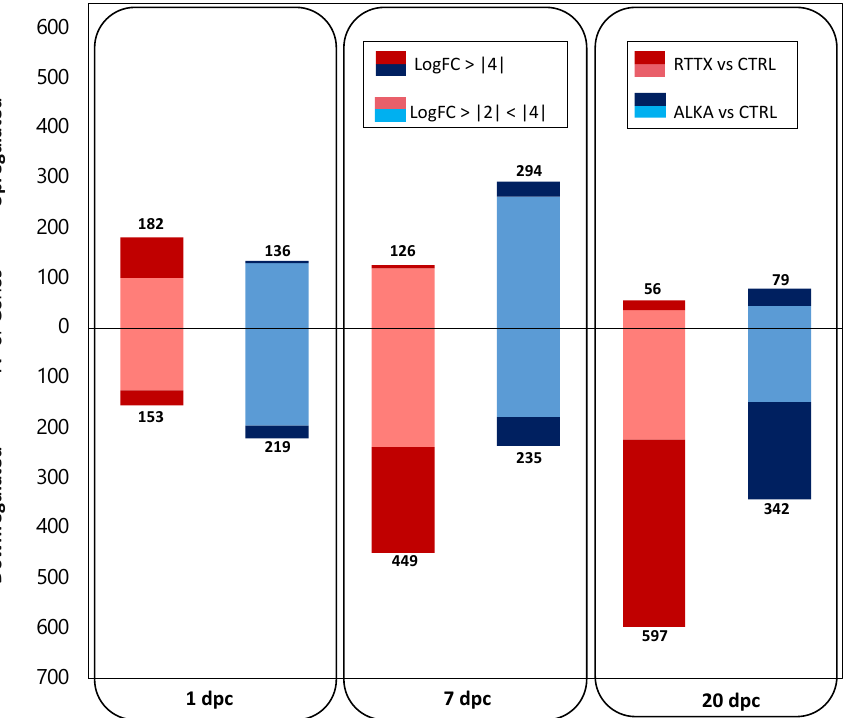
Figure 1. Number of differentially expressed genes (DEGs) in fish challenged with RTTX (pink and red) and ALKA (light blue and blue) when compared to the controls on days 1, 7, and 20 post- challenge. The DEGs were determined considering a Log2 Fold Change (LogFC) ≥ |2| and a p -value corrected for the false discovery rate (FDR) ≤ 0.01. Light tones (pink and light blue) show the genes with a LogFC ≥ |2| and <|4|, darker tones (red and blue) indicate the DEGs that presented a LogFC ≥ |4|.